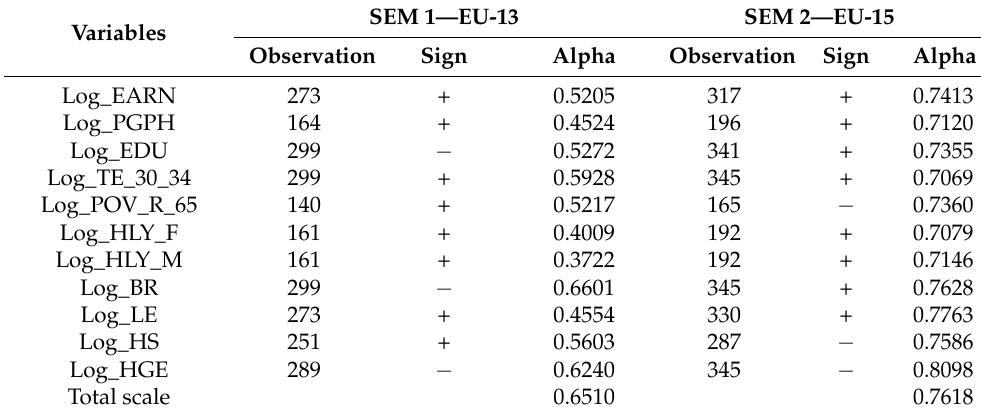
Table A3. Cronbach’s alpha for SEM, EU-13 and EU-15 models,